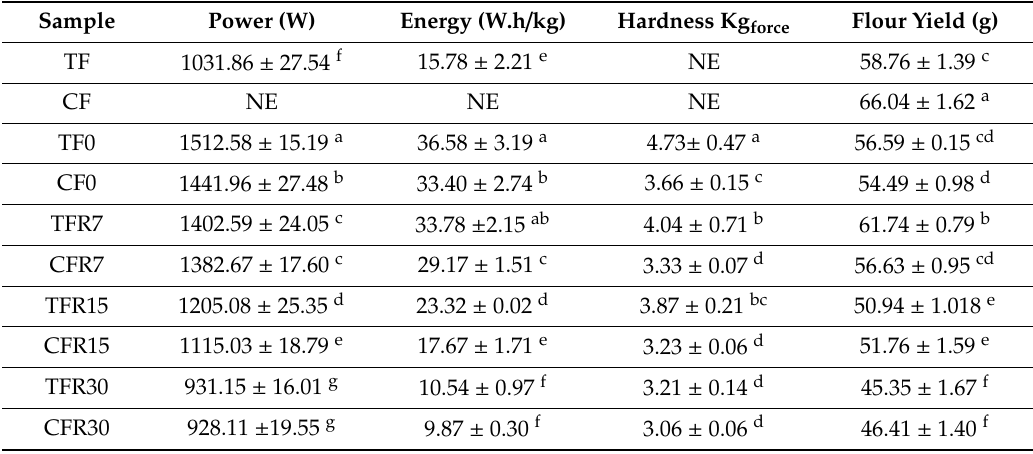
Table 1. Hardness, flour yield, power and energy consumption during grinding of corn tortillas obtained by the traditional and industrial (commercial)